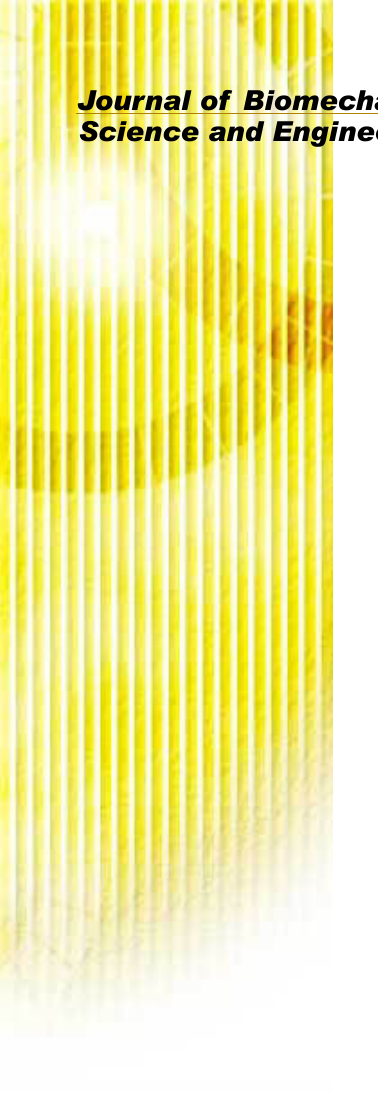
Initial growth factor distribution in both gel-bFGF and medium-bFGF model. The bFGF concentration rate between the bFGF concentration in the collagen gel and that in the medium of each model were measured using ELISA to observe the time course change of growth factor distribution. Data are mean ± S.D. ** P < 0.01 vs. medium-bFGF